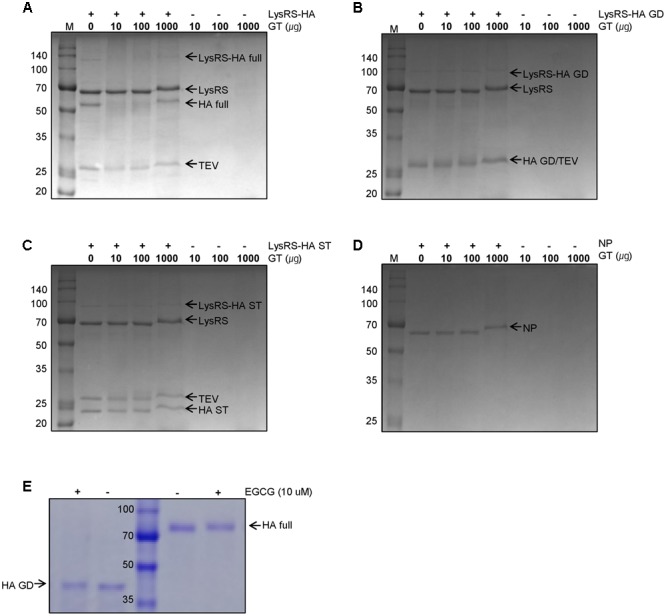
Modifications of influenza viral proteins by GT treatment. (A–C) Modification of influenza HA proteins by GT. E. coli-expressed LysRS-HA full-length (A), globular domain (GD) (B), and stalk (ST) (C) proteins were digested by TEV protease before GT treatment. The digested proteins were treated with the various concentrations of GT (0–1,000 ug) for 6 h at 35°C and were subjected to SDS–PAGE. (D) Modifications of influenza NP proteins by GT treatment. E. coli-expressed NP proteins were incubated with GT (10–1000 μg) for 6 h at 35°C and their molecular weight change was examined by SDS-PAGE. (E) Modification of HA proteins by EGCG treatment. E.coli-expressed rRBD-HA GD and HEK293 cell-expressed HA full-length proteins were incubated with 10 μM of EGCG for 2 h at RT and their mobility changes were analyzed by SDS-PAGE.